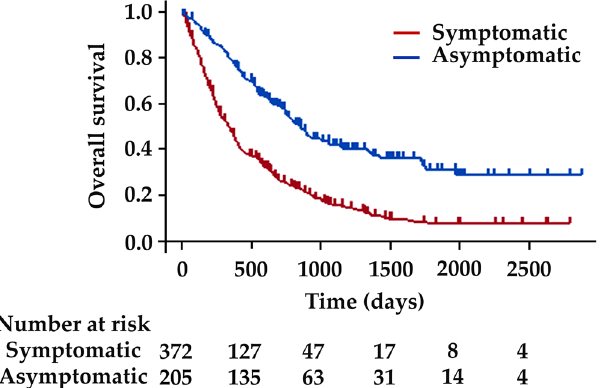
Figure 1. Kaplan–Meier survival curves of the patients with pancreatic ductal adenocarcinoma (PDAC) with or without symptoms. The overall survival of asymptomatic patients was better than that of symptomatic patients ( P < 0.001).